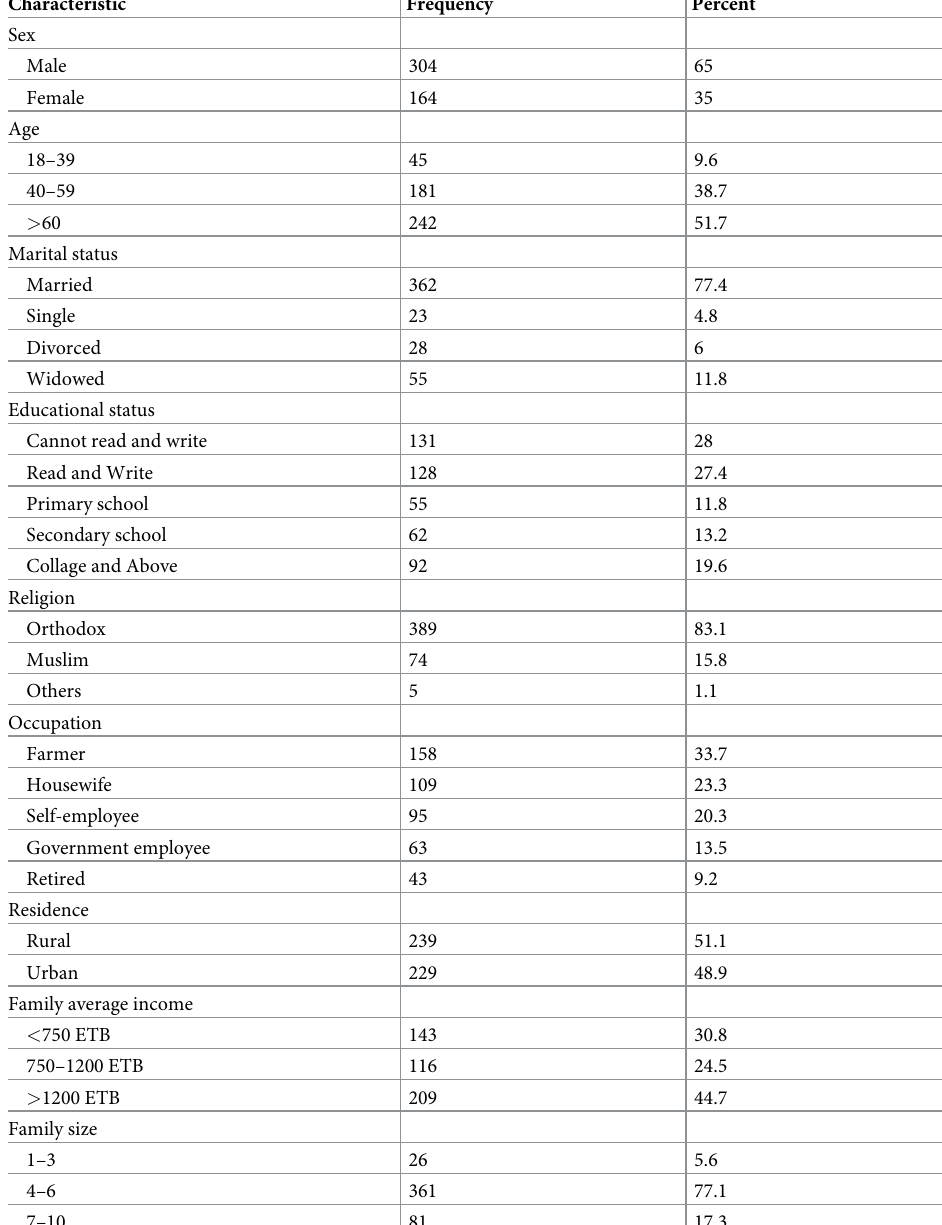
Table 1. Socio-demographic and economic characteristics of study